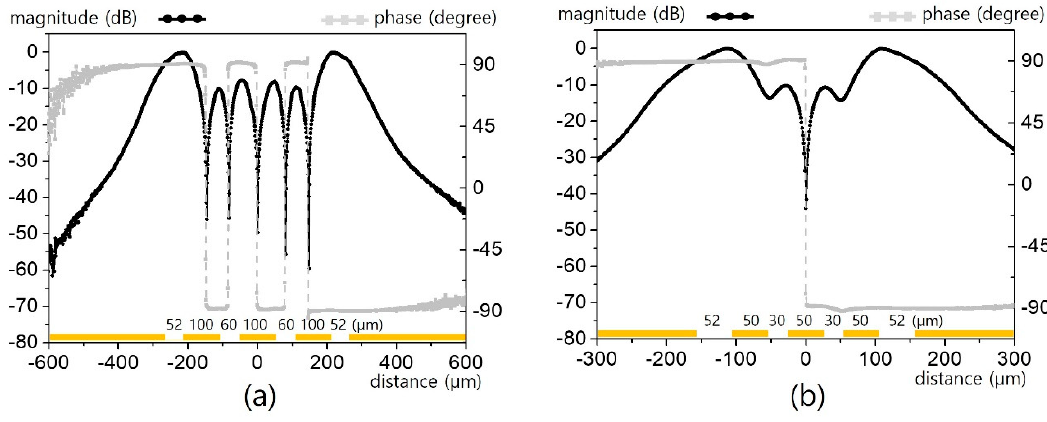
Figure 4. Horizontal electric field distribution over wide triple ( n = 3) CPW lines: ( a ) for L/g/G = 100/60/52 μ m, and ( b ) for L/g/G = 50/30/52 μ m.